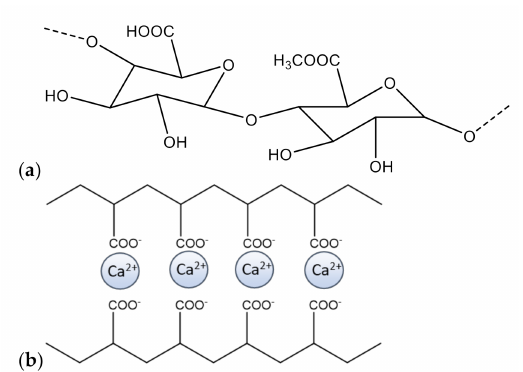
Figure 2. ( a ): pectin structure. ( b ): Schematic interaction between calcium ions and pectin COO −